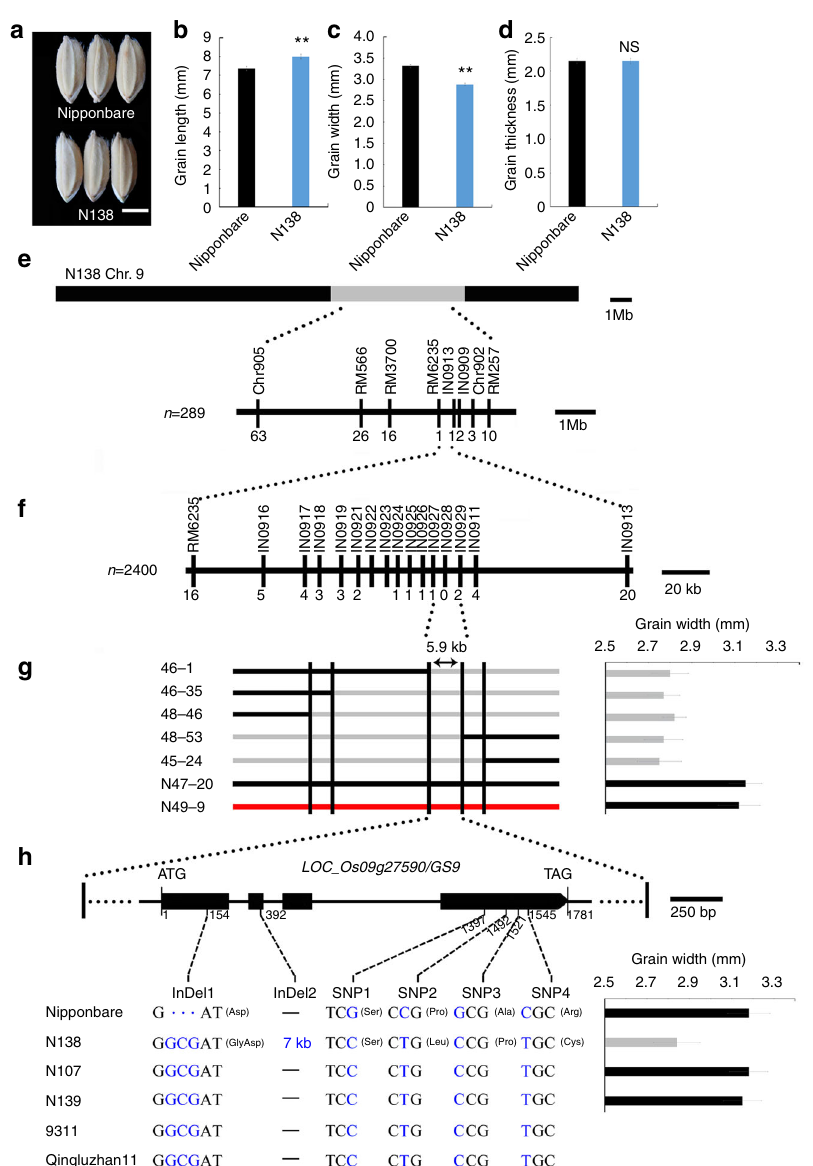
Fig. 1 Map-based cloning of GS9 . The morphology ( a ), length ( b ), width ( c ), and thickness ( d ) of mature grains from CSSL line N138 and its recipient Nipponbare. Scale bar, 3 mm. Data are given as means ± standard deviation (SD, n = 30); ** signi fi cant difference ( P < 0.01, t -test). NS not signi fi cant difference. e GS9 was preliminary mapped between markers RM6235 and IN0913 on chromosome 9 using 289 F 2 recessive individuals from the cross of N138 and Nipponbare. f GS9 was narrowed down to a 5.9-kb genomic DNA region between markers IN0927 and IN0929 using 2400 F 3 recessive individuals. The numbers below the bar in panels e and f indicate the number of recombinants between GS9 and the molecular markers shown. g Genotype (left) and grain width (right) were shown for recombinant plants and the control plants. Black and gray bars represent chromosomal segments homozygous for Nipponbare and N138 alleles, respectively, while red one indicates heterozygous. h Schematic representation of the structure and allelic variation of the candidate gene LOC_Os09g27590 (GS9) , the only one predicted open reading frame in the 5.9-kb delimited region, among three CSSLs and their parents. The numbers below the gene bar indicate the number of polymorphic nucleotide(s) located in coding region, where the fi rst nucleotide of start codon is as No. 1. Differential nucleotides are shown in blue and resulting amino acids are in brackets. The grain width of three CSSLs and their recipient Nipponbare is shown on the